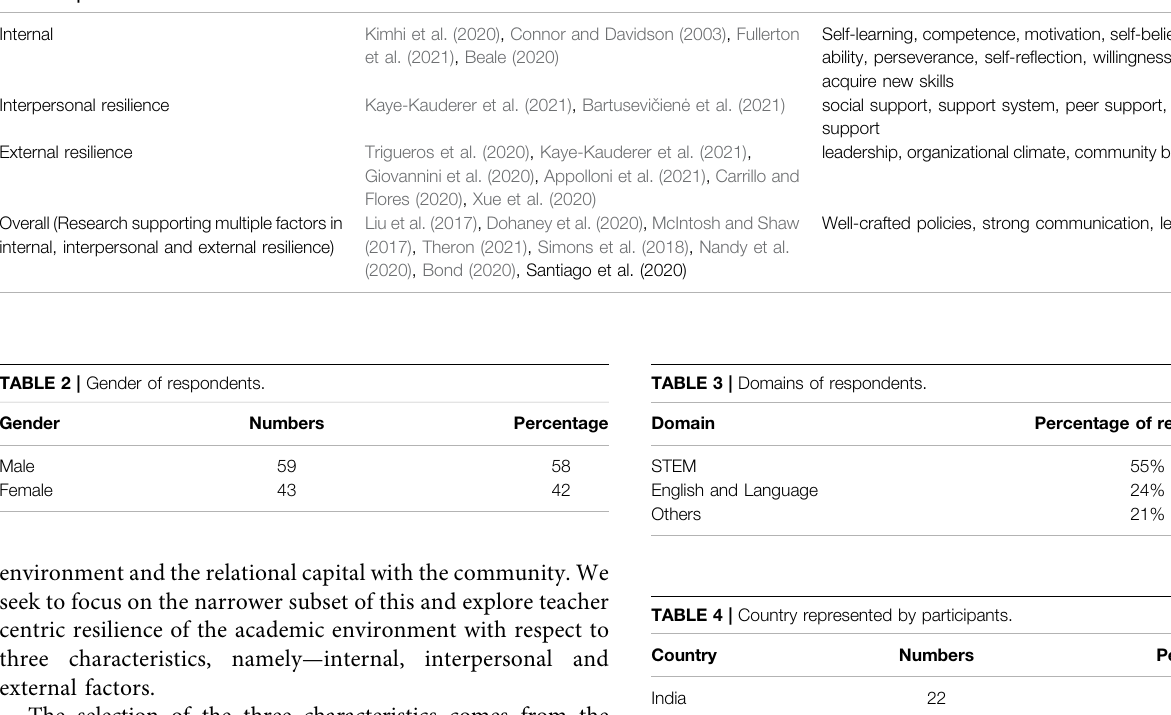
TABLE 1 | Factors in Teacher resilience.